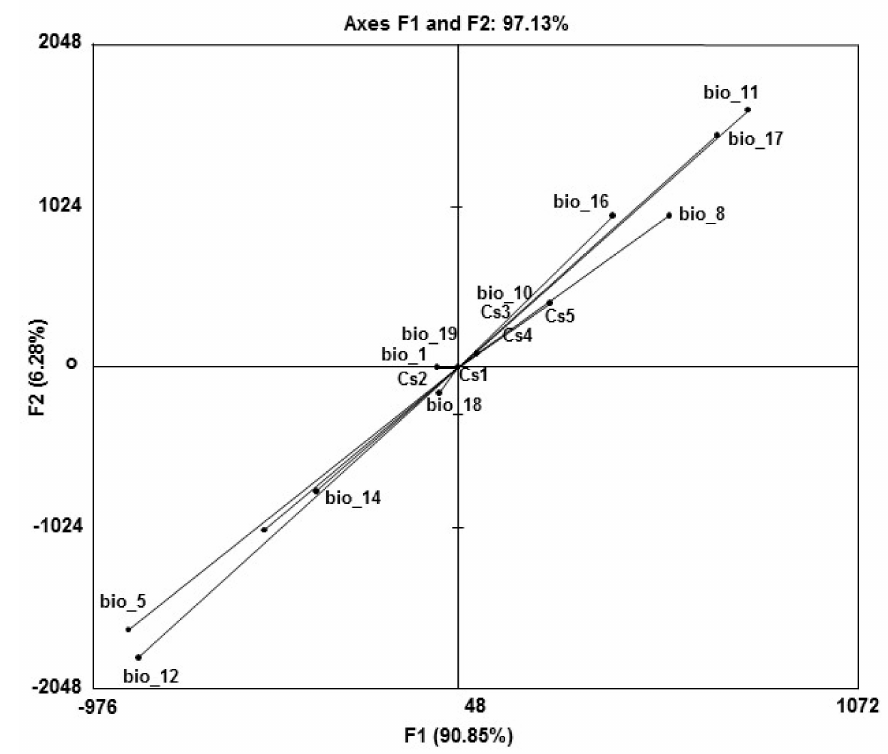
Figure 4. Canonical Correspondence Analysis (CCA) of each stage class (Cs1.Csn) (in the nine O. mexicana populations) and their association with environmental variables. Quantitative environmental variables are indicated by arrows. The length of the arrows describes the relative importance of each analyzed variable, and the direction of the arrow indicates among variables